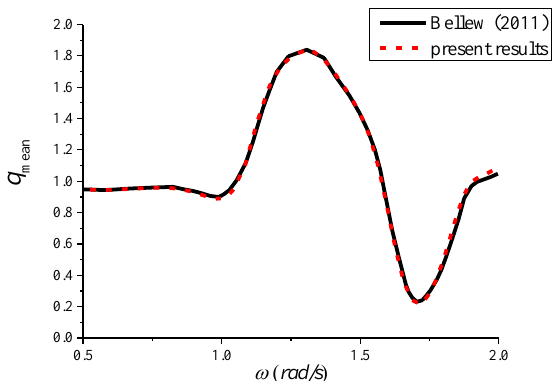
Figure 3. Comparison of the calculated mean interaction factor q mean with the numerical results in [39].